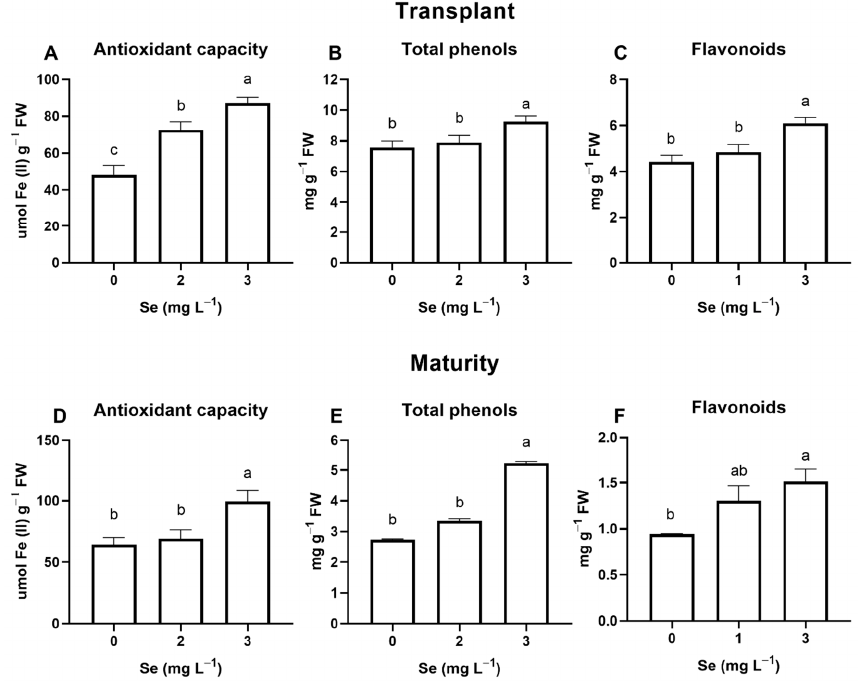
Figure 9. Antioxidant capacity, total phenol and flavonoid contents, measured at transplant ( A – C ) and maturity ( D – F ), in leaves of basil plants treated with different concentrations of Se at pre-transplanting. Means ( n = 3) flanked by different letter are statistically different for p = 0.05 after Tukey ’ s test.